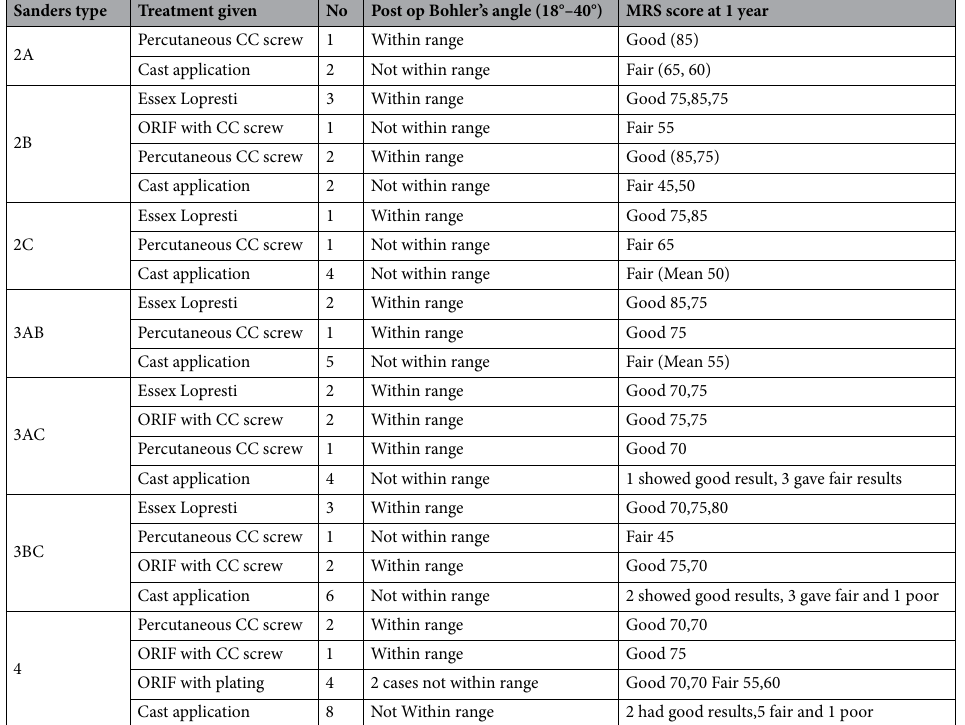
Table 2. Results of different Sanders types and treatment modalities.